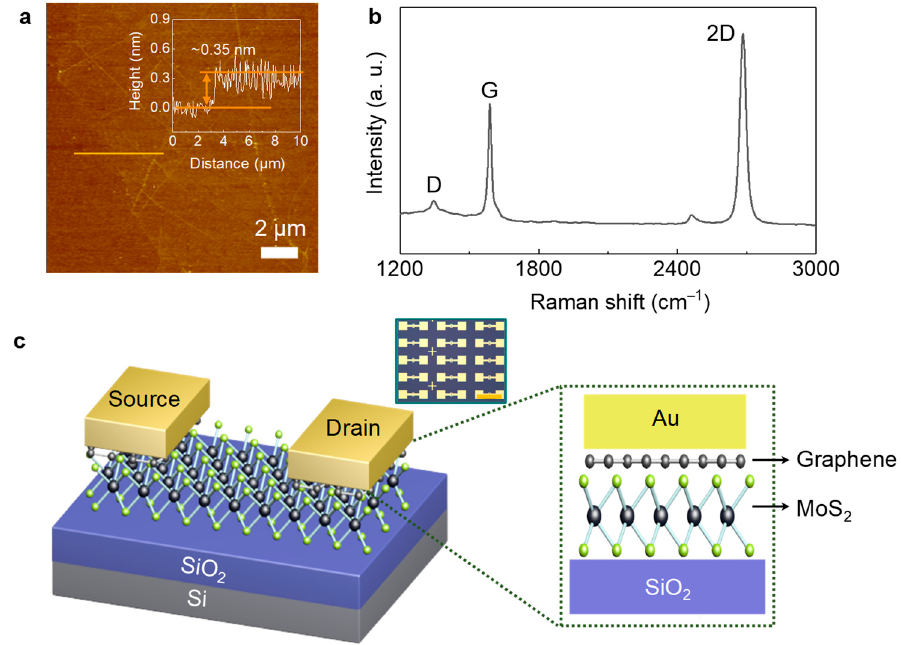
Figure 2. ( a ) AFM image and ( b ) Raman spectrum of graphene films synthesized by CVD. The wet-transfer process was used to transfer the films onto a Si/SiO 2 substrate. ( c ) Schematic image of MoS 2 devices with graphene/Au contacts (inset: optical microscopy image of MoS 2 device arrays with graphene/Au contacts. Scale bar denotes 500 μ m).